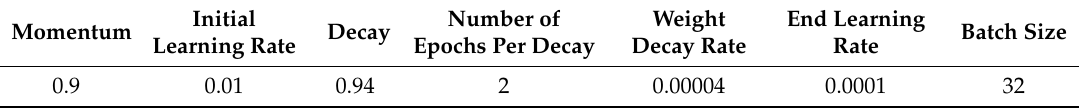
Table 3. Hyperparameters used in the fine-tuning of an Inception V3